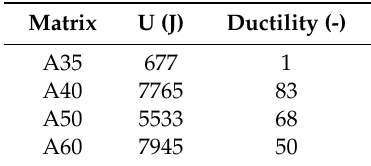
Table 4. Strain energy and ductility.